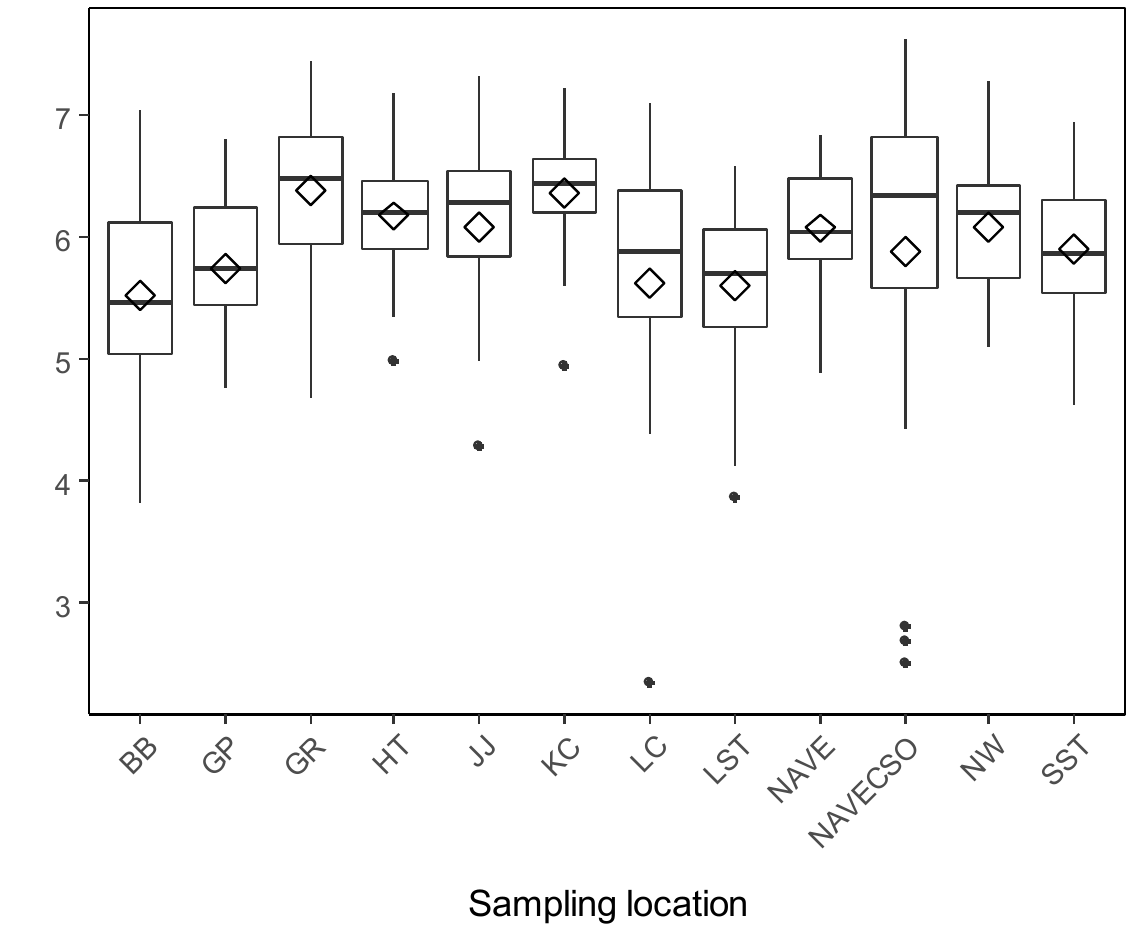
Figure 2. Abundance of 16S rRNA gene copies in surface water samples across the sampling points. The boxplots show the 25th quartile, 75th quartile, and median lines. The diamond shape represents the mean observations for each site, whilst outliers are represented by the solid points.